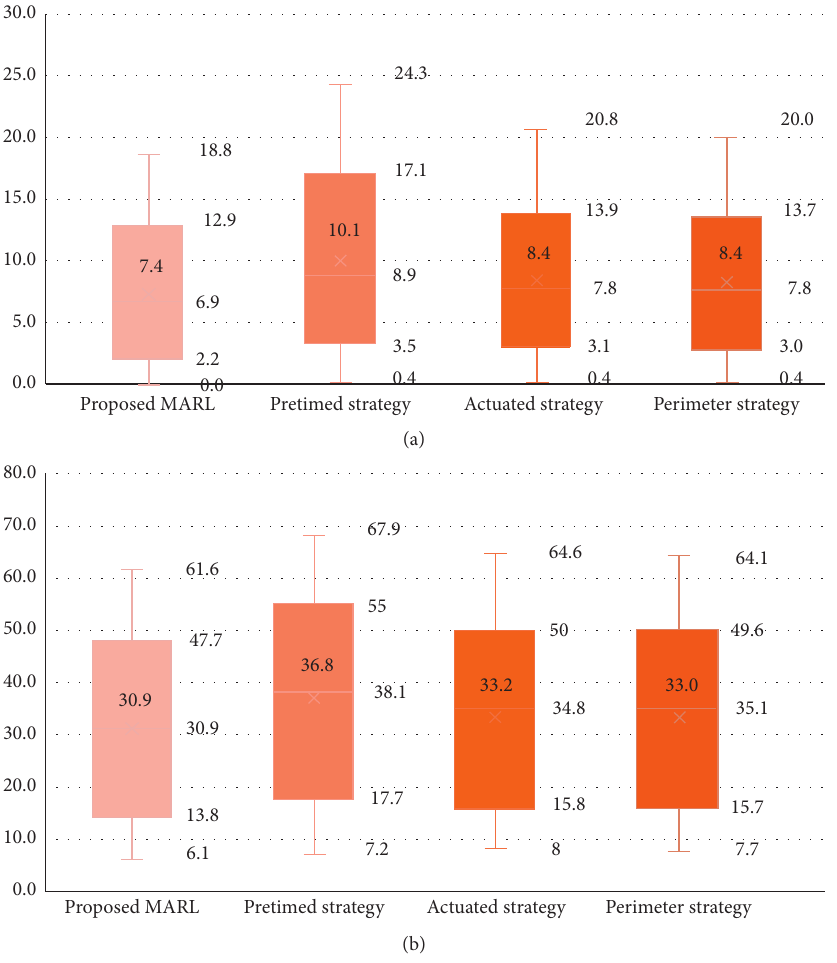
Figure 4: Box plots for traffic parameters controlled by different strategies. (a) Box plots for average intersection queue length. (b) Box plots for average intersection waiting